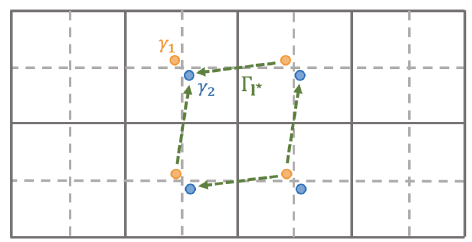
Figure 2. Illustration for the Γ l ? operators. The arrows represent the order of the fermion operators in the